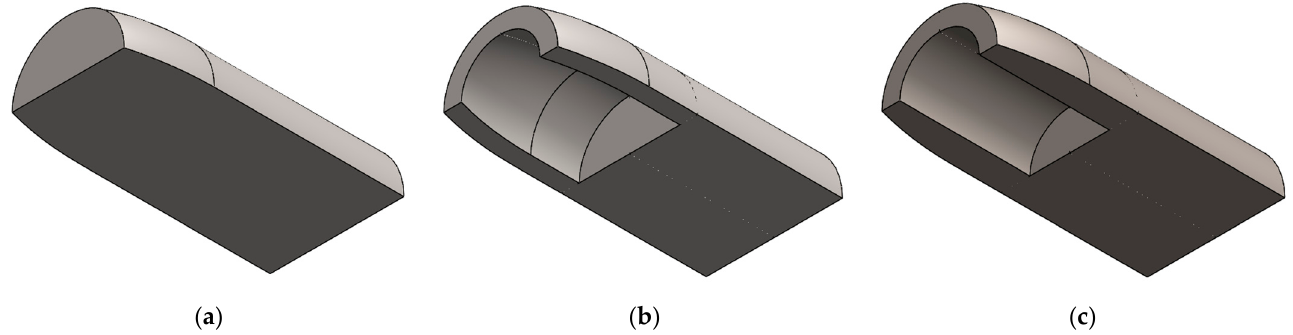
Figure 6. Different types of mandrel: ( a ) ordinary non-ball mandrel, ( b ) hollow mandrel scheme 1, and ( c ) hollow mandrel scheme 2.